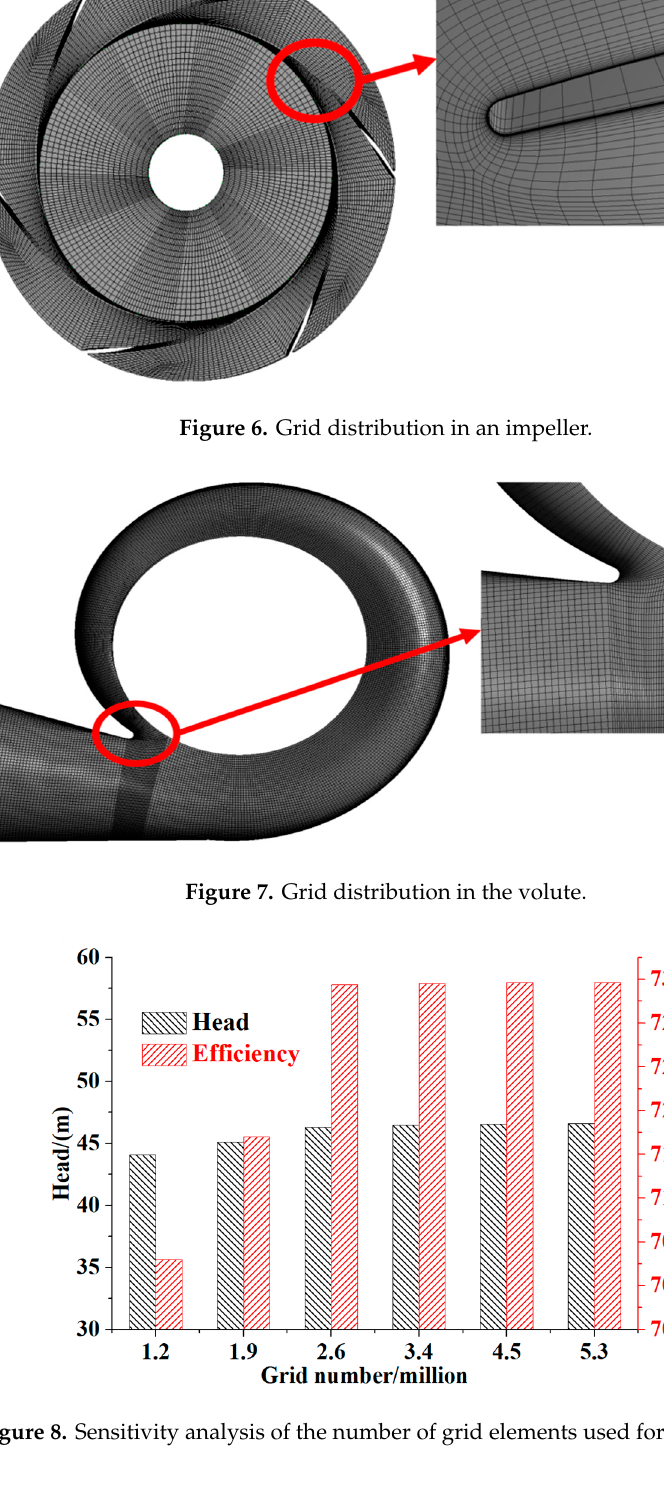
Figure 8. Sensitivity analysis of the number of grid elements used for the solution.